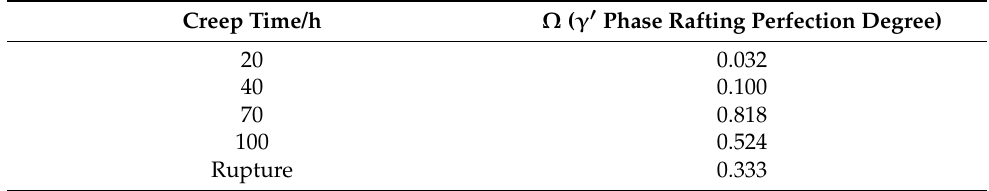
Table 4. γ (cid:48) phase rafting perfection